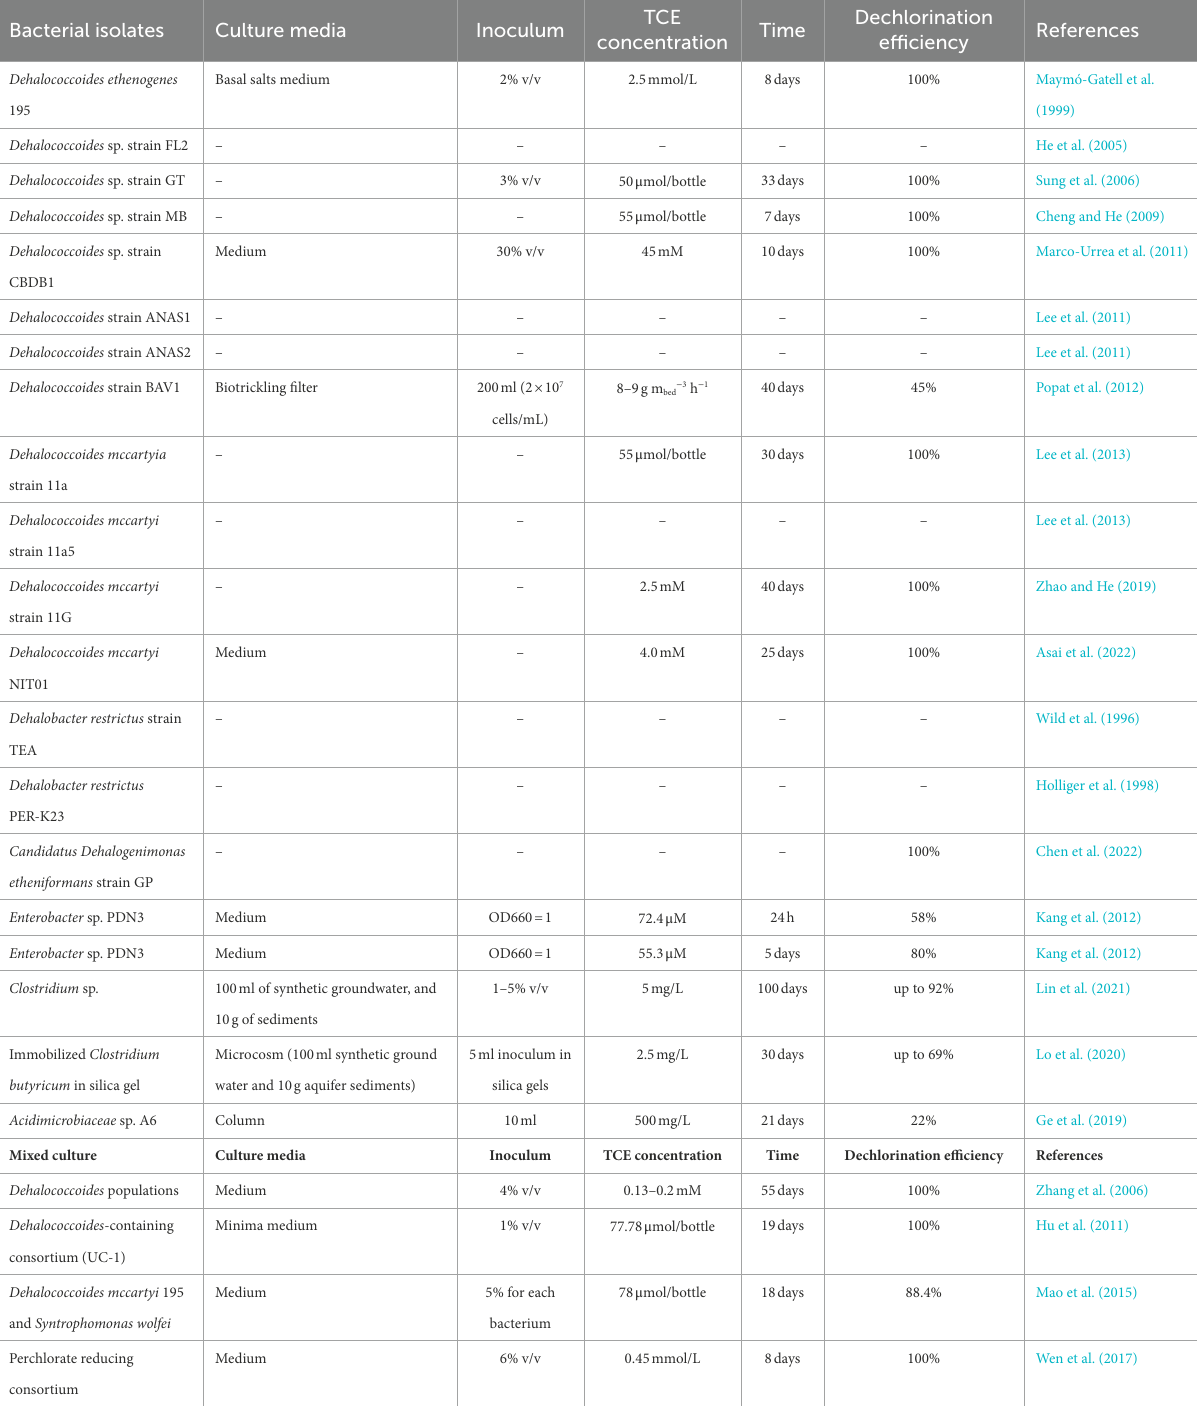
TABLE 3 Summary of anaerobic reductive dechlorination of TCE by bacterial isolates and mixed